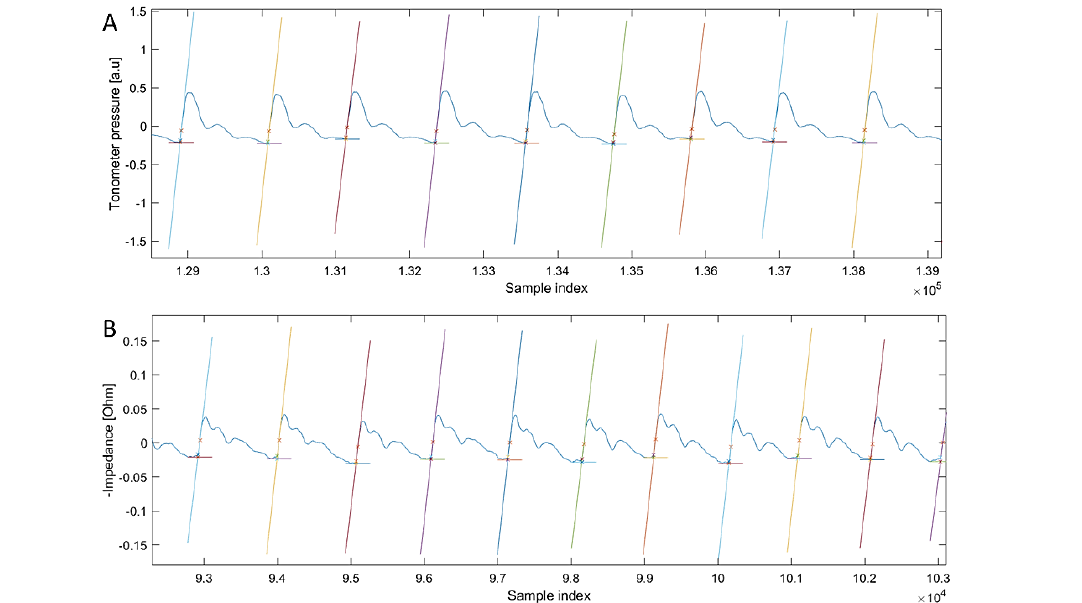
Figure 2: Analysis with the intersecting tangents method of the pulse wave forms to estimate the pulse arrival time showing part of two example recordings. (A) Tonometer. (B) Negative value of